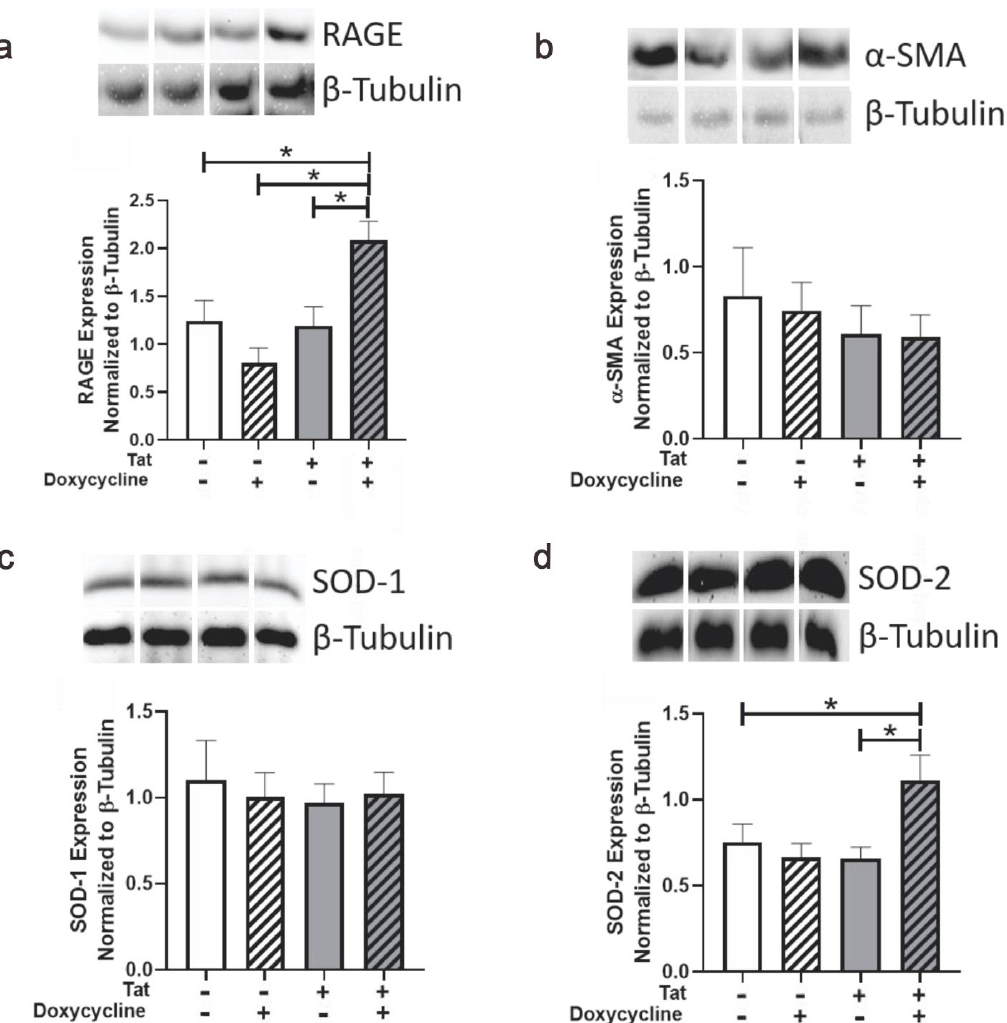
Figure 4. Effect of Tat Expression on the Cardiac Biomarkers of Transgenic Tat Adult Male Mice. Compared to Tat( − ) controls, Tat(+) mice (n = 7 − 8/group) demonstrated upregulation of ( a ) RAGE and ( d ) SOD-2, but not ( b ) α− SMA or ( c ) SOD-1; * p ≤ 0.05; one-way ANOVA followed by Tukey’s HSD.